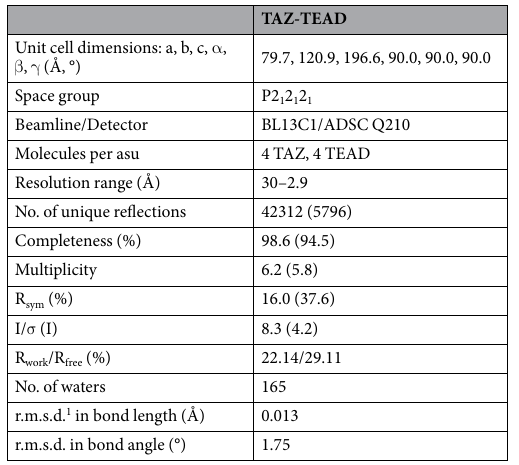
Table 1. Data collection and refinement statistics for TAZ-TEAD complex. 1 r.m.s.d. is the root-mean-square deviation from ideal